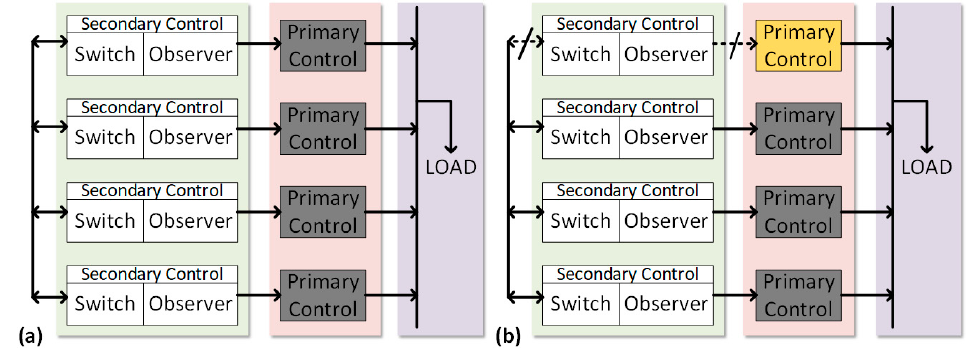
Figure 2. DC micro-grid (MG): ( a ) Regular 4-node DC MG; ( b ) Communication fault 4-node DC MG.